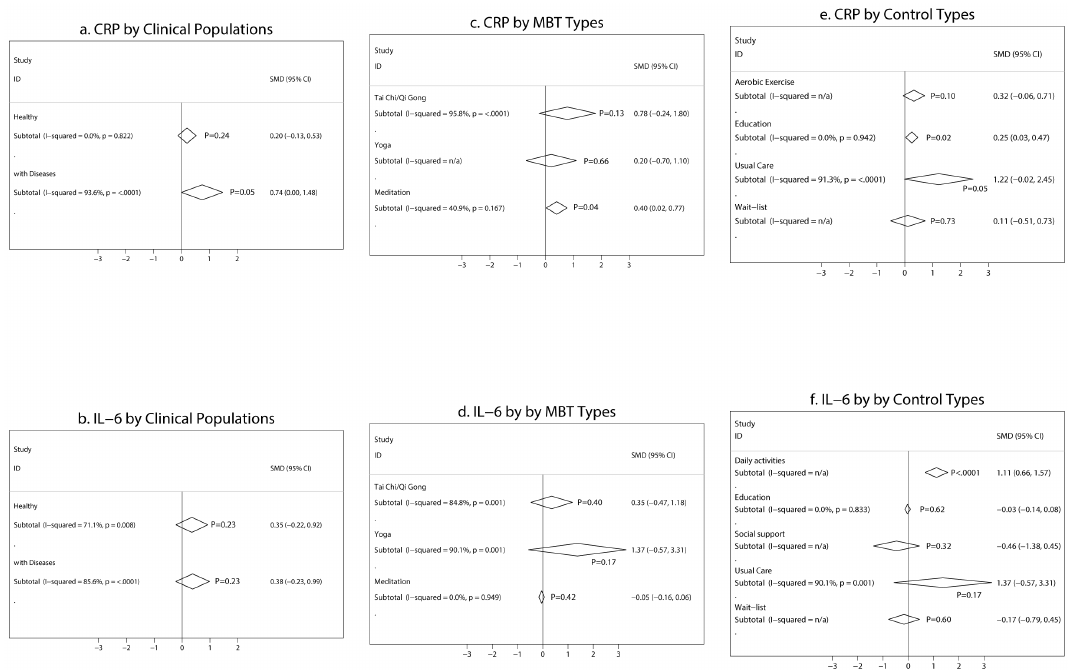
Figure 3. Subgroup meta-analysis of RCTs comparing the effect of mind-body therapies with control interventions on CRP and IL-6 by clinical populations (panels a and b), by MBT types (panels c and d), and by control types (panels e and f). Legends: SMD=standardized mean difference. MBT=mind-body therapies. P-values adjacent to I-squared results are p-values for heterogeneity testing (P , 0.05 indicates significant heterogeneity and ‘‘I-squared=n/a’’ indicates that there was only 1 study in the subgroup so heterogeneity was not applicable), and p-values adjacent to meta-analysis pooled results (diamonds) are p-values for the pooled effect sizes.